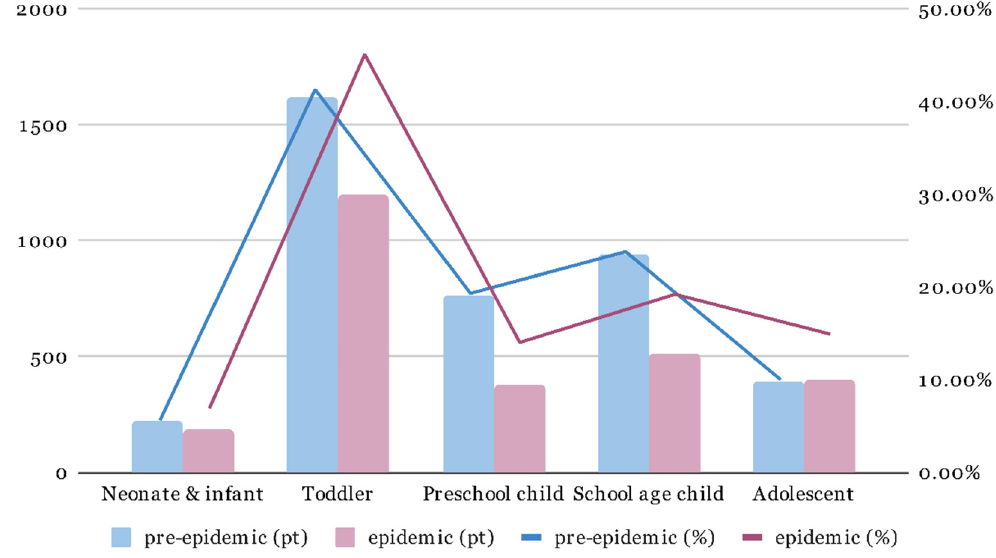
Figure 3. Age distribution of patients seen by EM residents. (Neonate & infant, 0 year; toddler, 1–3 year; preschool child, 4–5 year; school age child, 6–12 year; adolescent, 13–18 year).